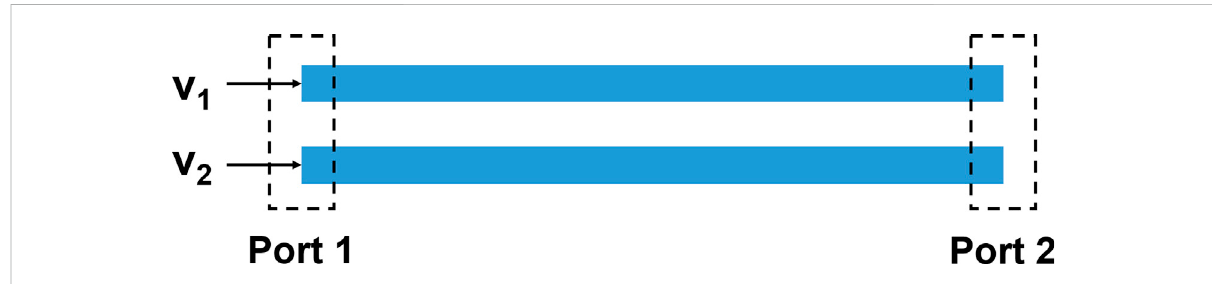
FIGURE 3 Schematic diagram of differential transmission lines.